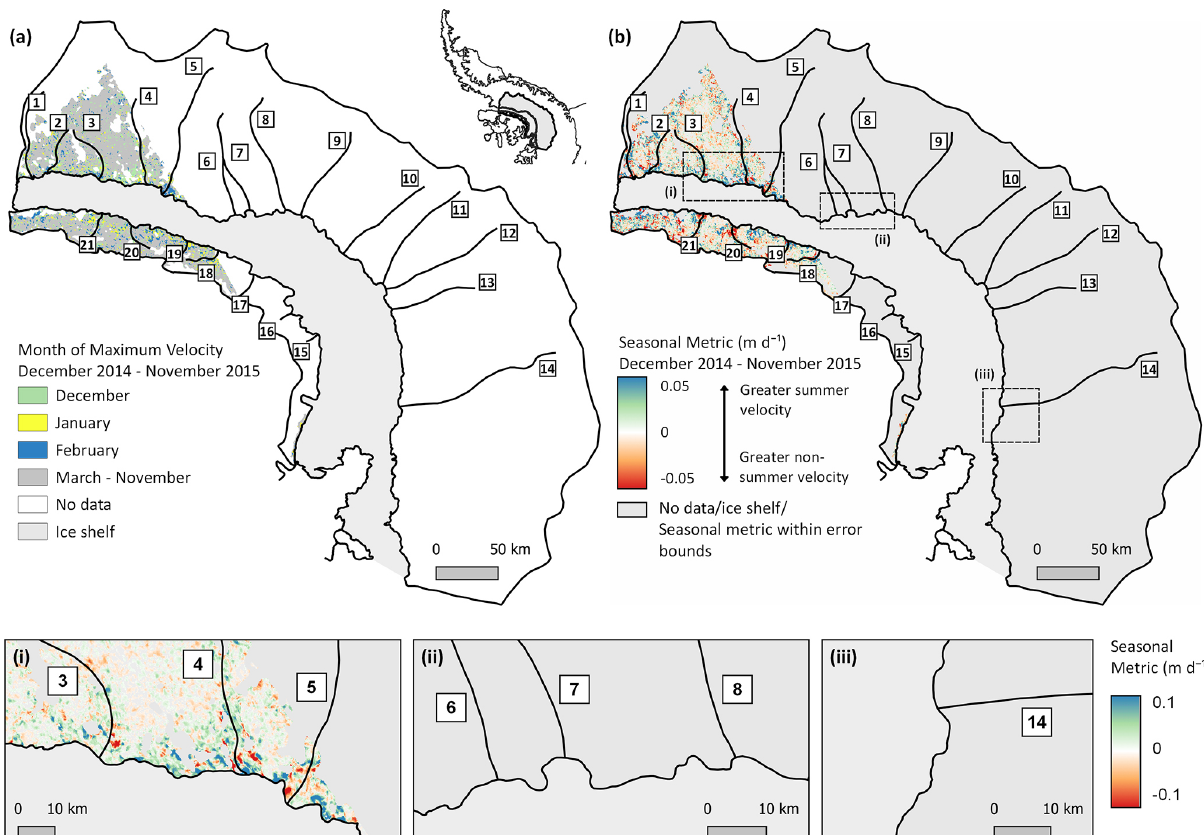
Figure B1. Same as Fig. 3 but showing spatially resolved patterns of seasonal ice flow as observed between December 2014 and Novem- ber 2015. Panels (a) shows the month of maximum velocity ( v time ) and (b) the calculated velocity anomaly ( v anom velocity anomalies (blue) indicate summertime speed-up and negative (red) greater velocity during non-summertime months. Dashed boxes denote the location of the inset boxes (i–iii). Note that insets ii and iii contain no data for the period December 2014–November 2015. See also Figs.